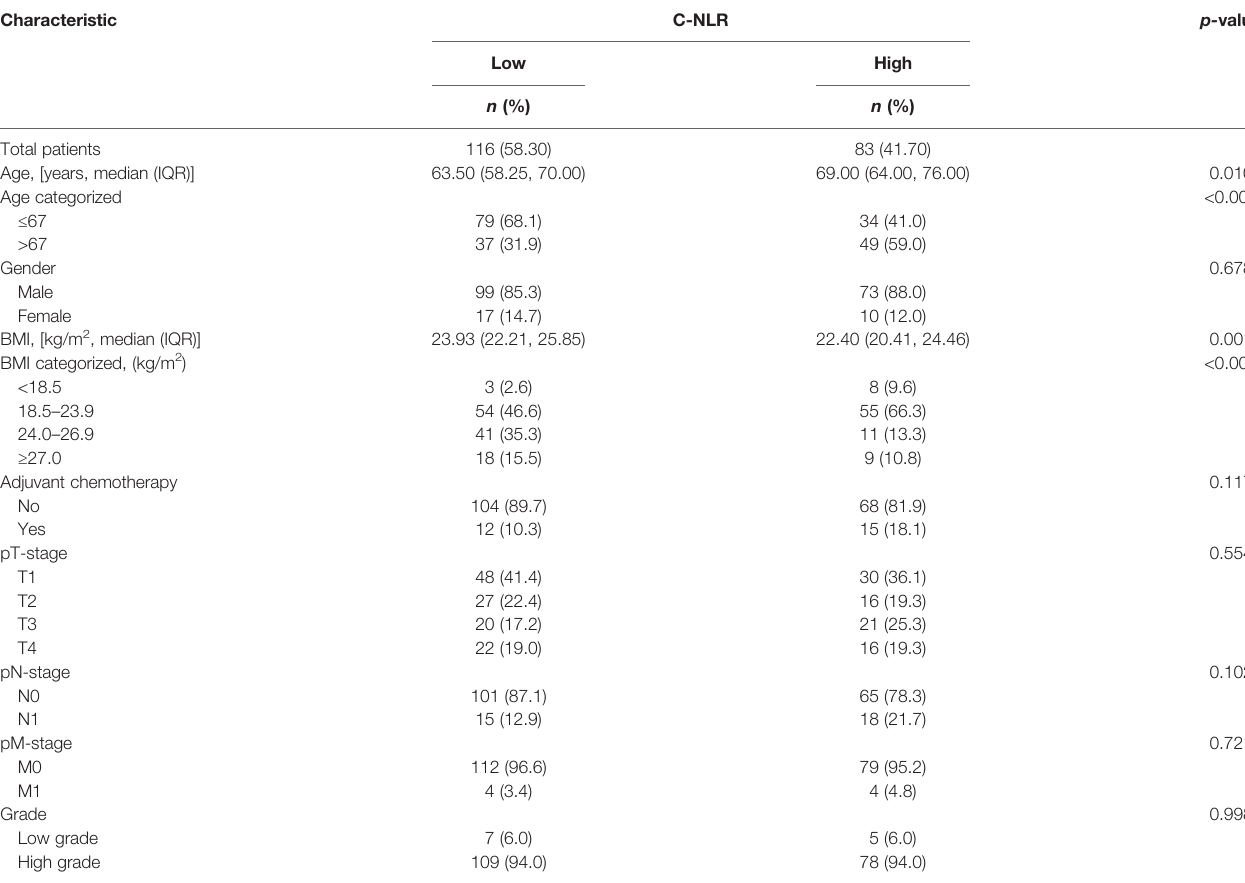
TABLE 3 | Baseline characteristics according to the subgroups classi fi ed by C-NLR. Characteristic